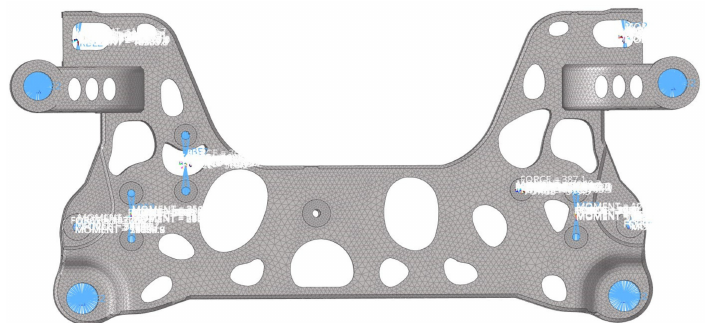
Figure 4. Establishment of displacement and load boundary conditions for aluminium alloy front subframe.